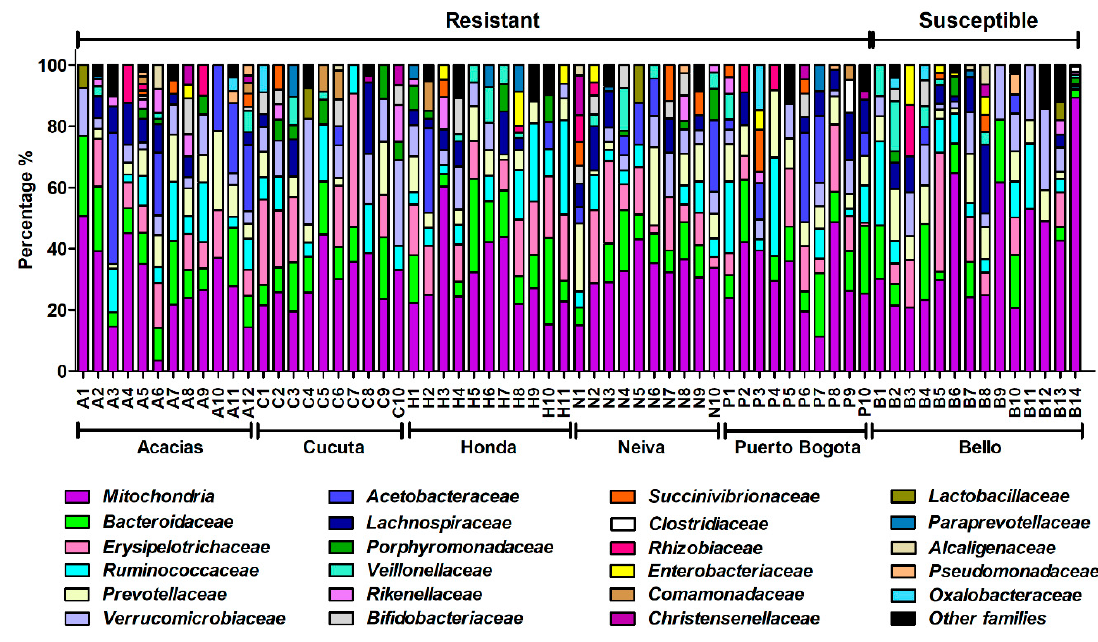
Figure 7. Comparison of the abundance of bacteria analyzed at the family level between lambda-cyhalothrin-resistant and -susceptible mosquitoes from six Colombian cities.